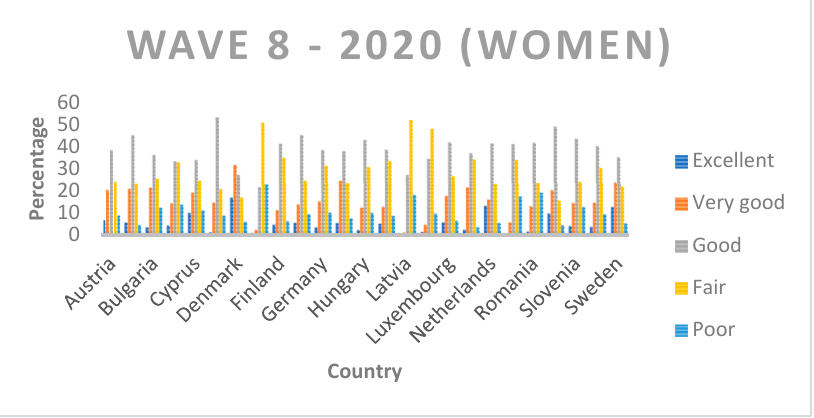
Figure A5. Distribution of men in Wave 8 (2020). Source: Authors’ elaboration based on SHARE (2021).